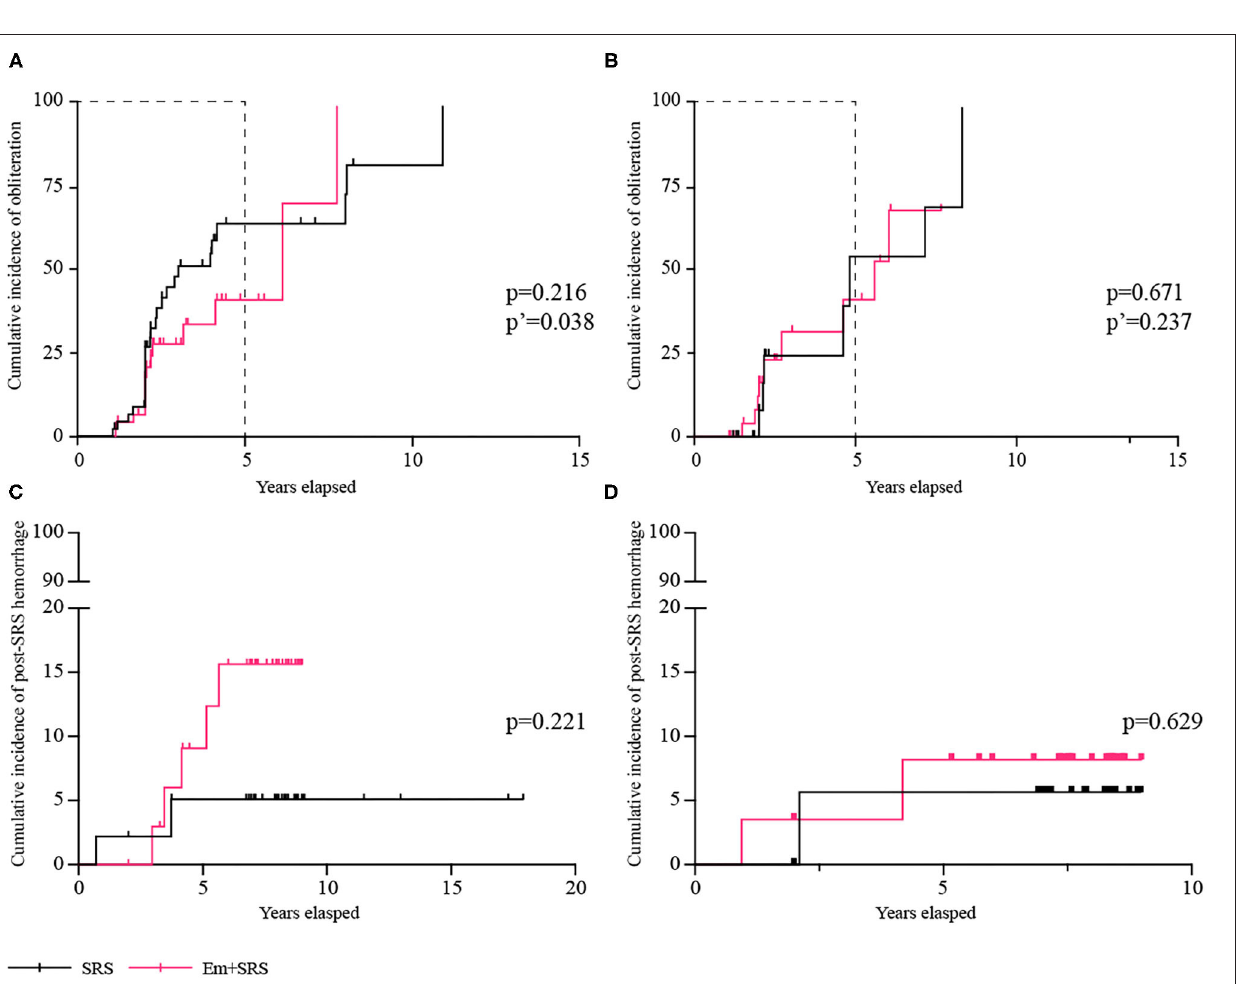
Frontiers in Neurology |